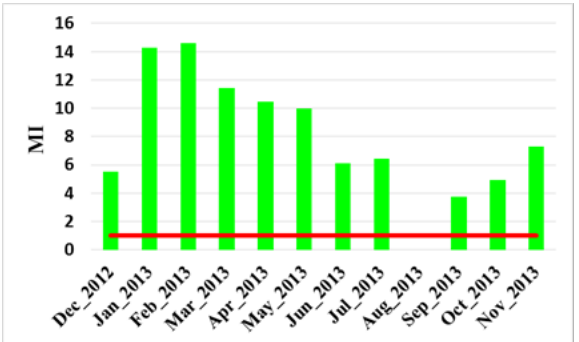
Fig.3 Metal Index (MI) of studied samples of Silakhor River at various sampling